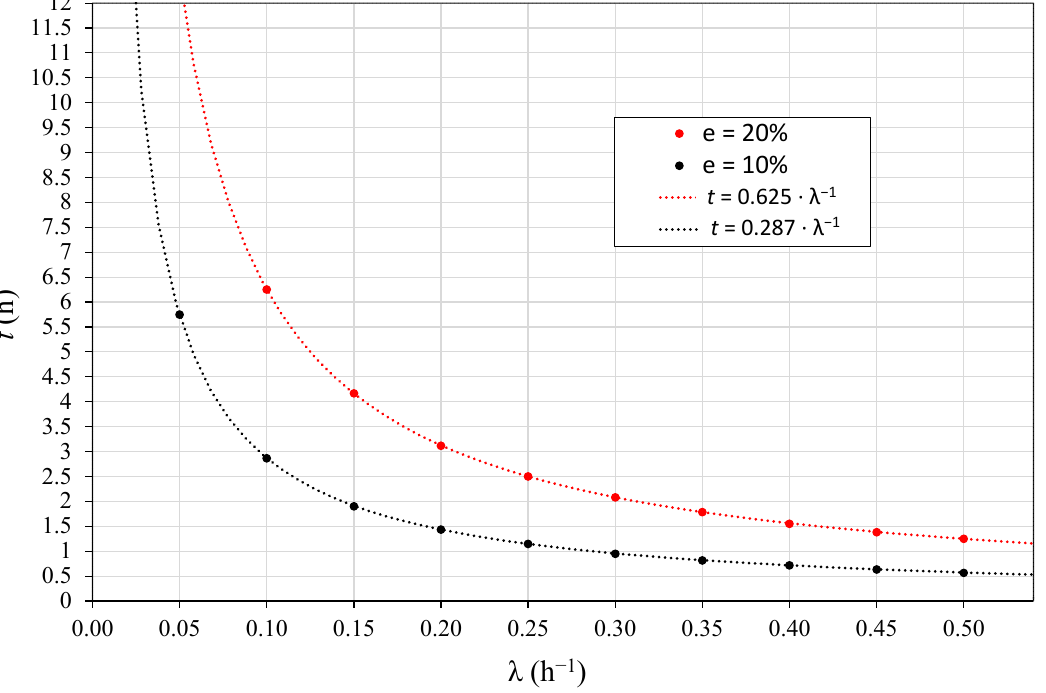
Figure 6. Theoretical estimation of time to be considered in the radon flux linear fitting calculation to not exceed a difference of 10% and 20%.